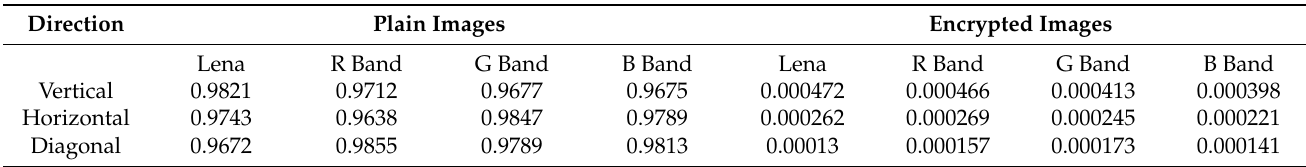
Table 5. Correlation coefficients of the proposed